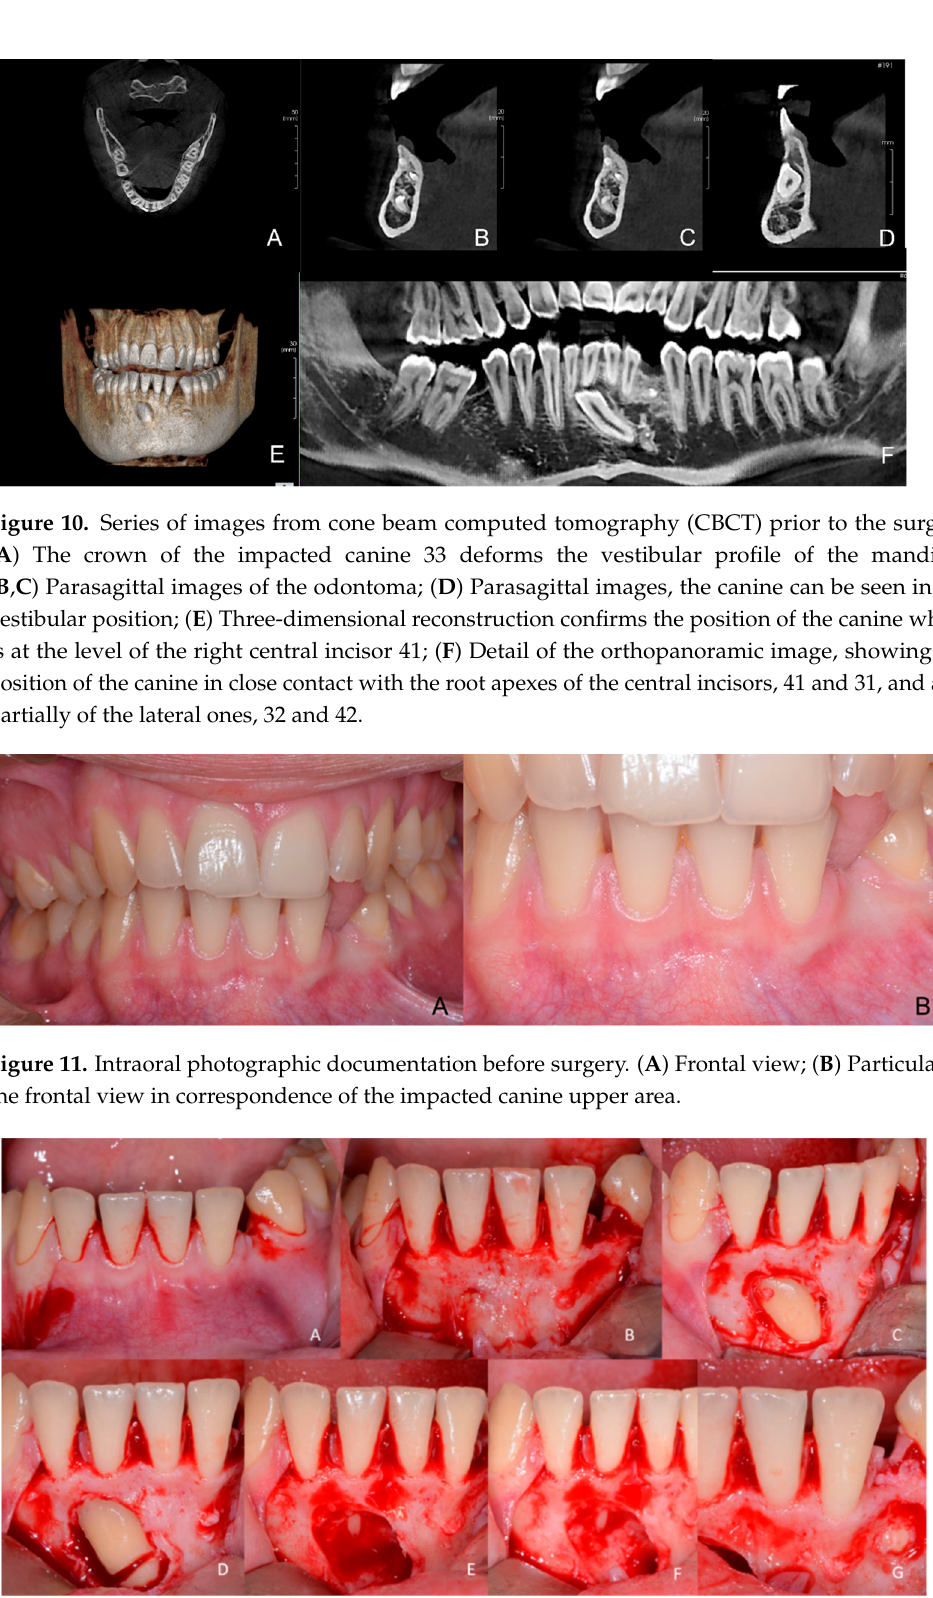
Figure 12. Pictures of the surgical procedure. ( A ) Flap design performed with the relief cut distal to 43, then within the gingival sulcus of the incisors; ( B ) After full thickness buccal flap the skeletonization of the bone, the included tooth is already visible, the bone is removed to remove the fibrotic sac present around the crown; ( C ) The crown is fully exposed; ( D – E ) To make it possible to extract the impacted canine, the tooth is cut, then the crown is extracted first and then the root; ( F ) After completing the extraction, the residual bone cavity and dental structure, if visible, is analysed. In this case, the root apex of 41 is visible and the vitality of this tooth will be evaluated during the